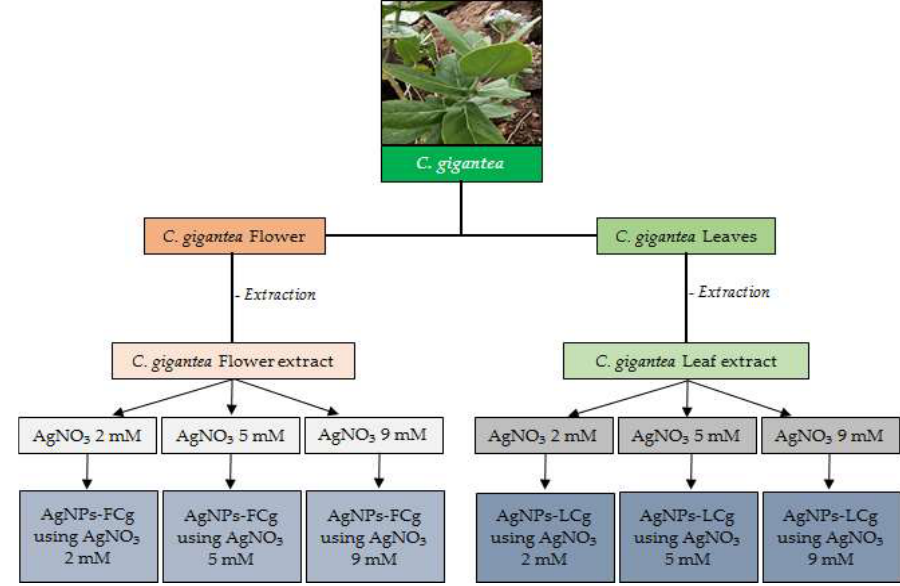
Figure 8. Schematic diagram of the green synthesis of AgNPs-LCg and AgNPs-FCg.